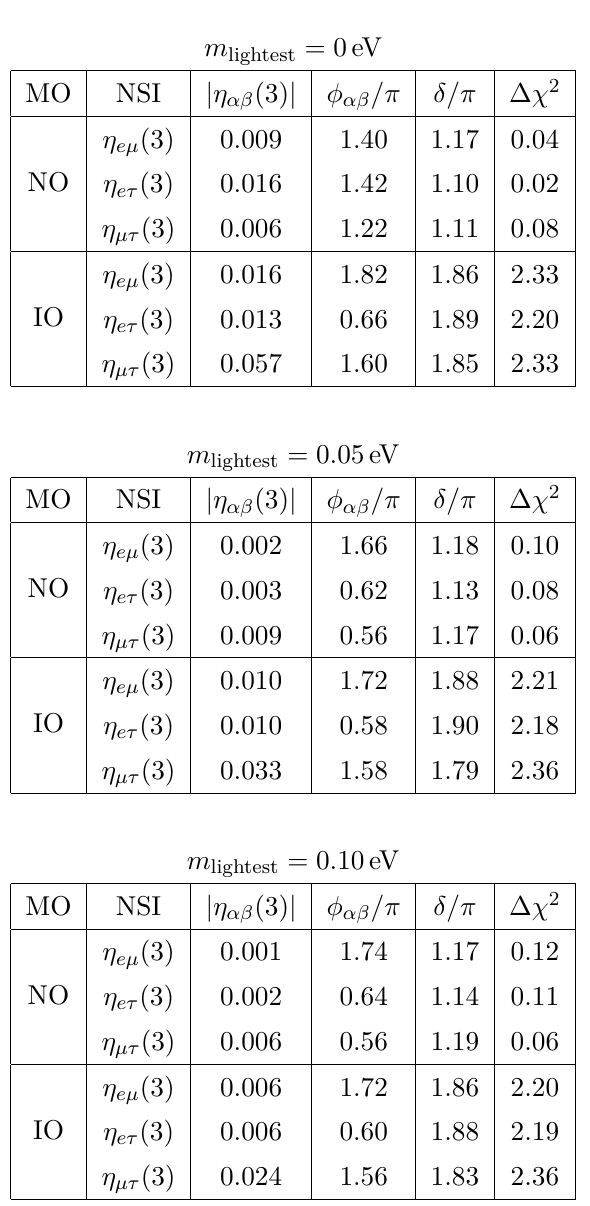
for a fixed MO considering − χ 2 SM NSI . (For the SM, χ 2 = 2 . 3 − χ 2 lightest NO IO